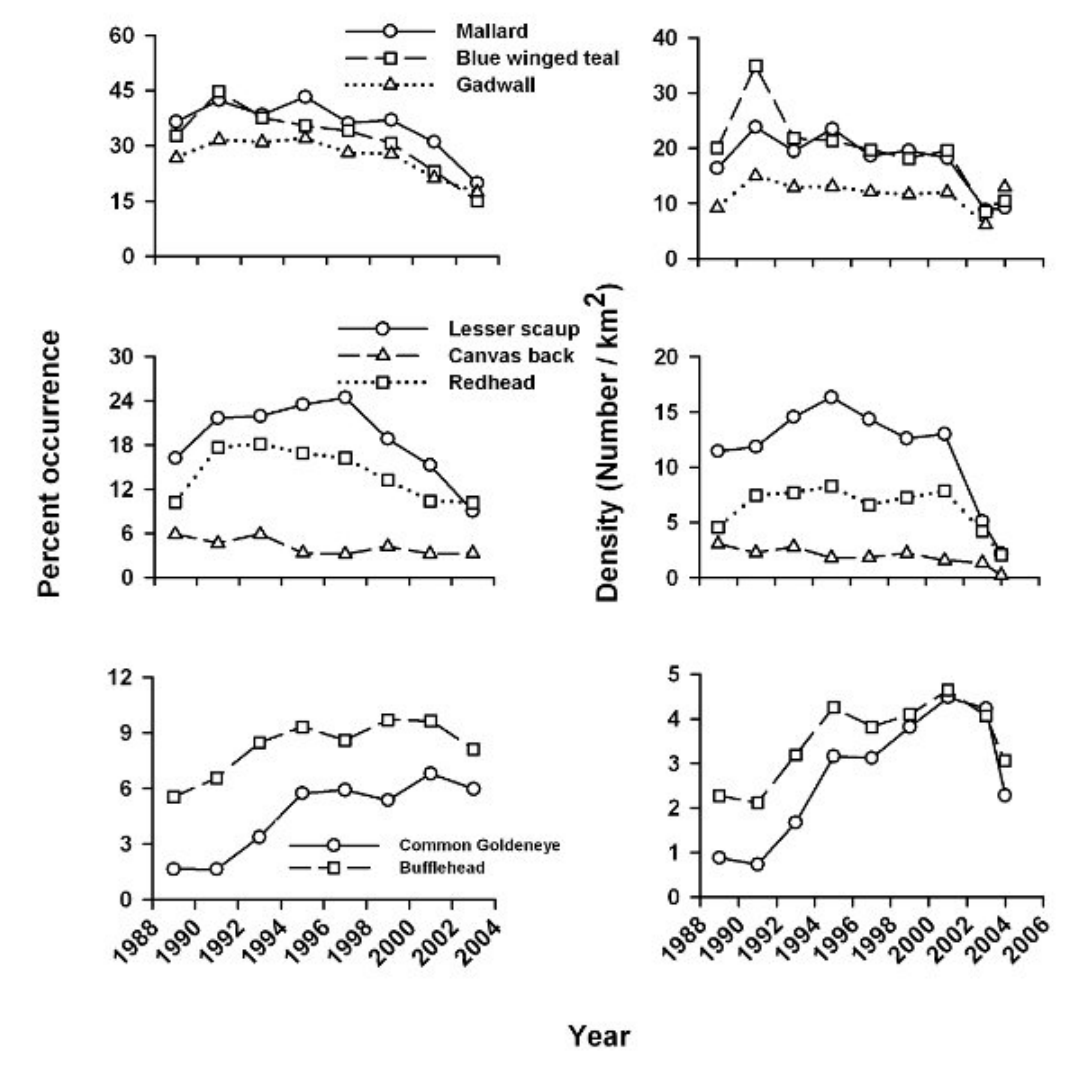
Fig. 5. Temporal patterns in the percent occurrence and density (Number / km²) of Common Goldeneye ( Bucephala clangula ) and Bufflehead ( Bucephala albeola ) and six other species of waterfowl between 1989 to 2004 in the Buffalo Lake Moraine. Data are based on biannual surveys of 1275 - 1444 wetlands between 1989 and 2003 (percent occurrence) and 1989 to 2004